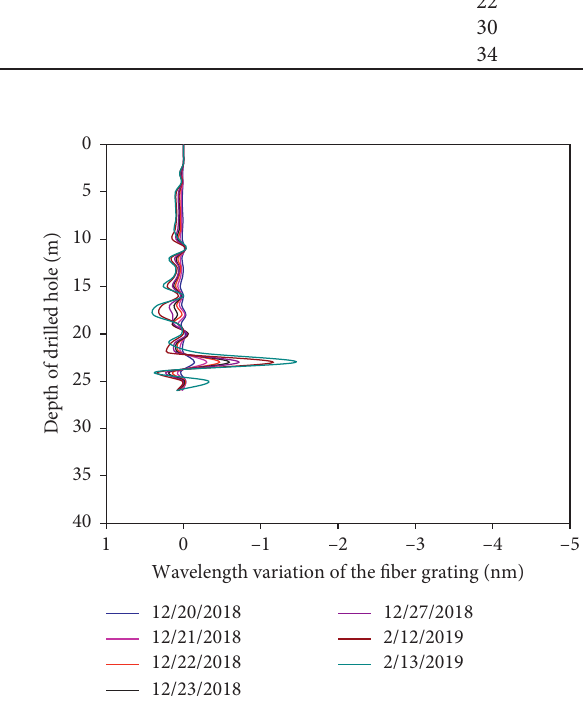
Figure 12: Wavelength of fiber grating at D 3.